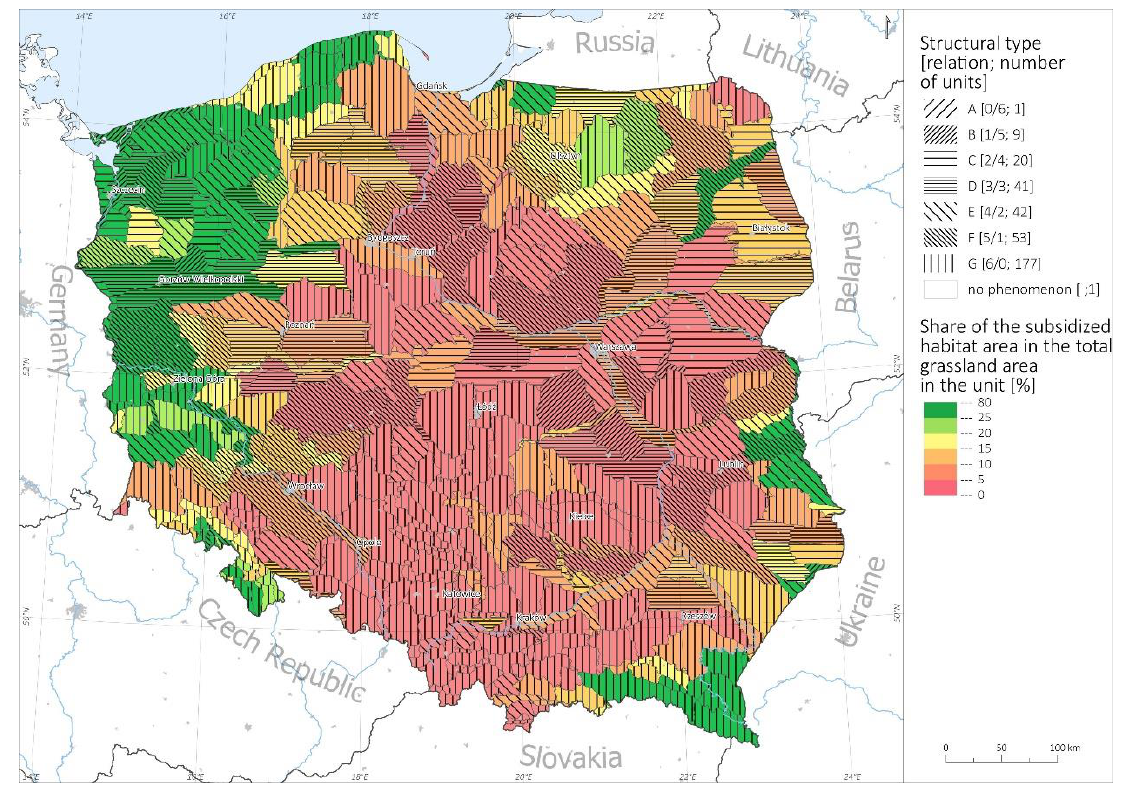
Figure 15. Relationship between natural habitat types subsidised under RDP 2014–2020, and percentage share of subsidised habitats in the total area of permanent grasslands (Source: Authors based on ARMA data).